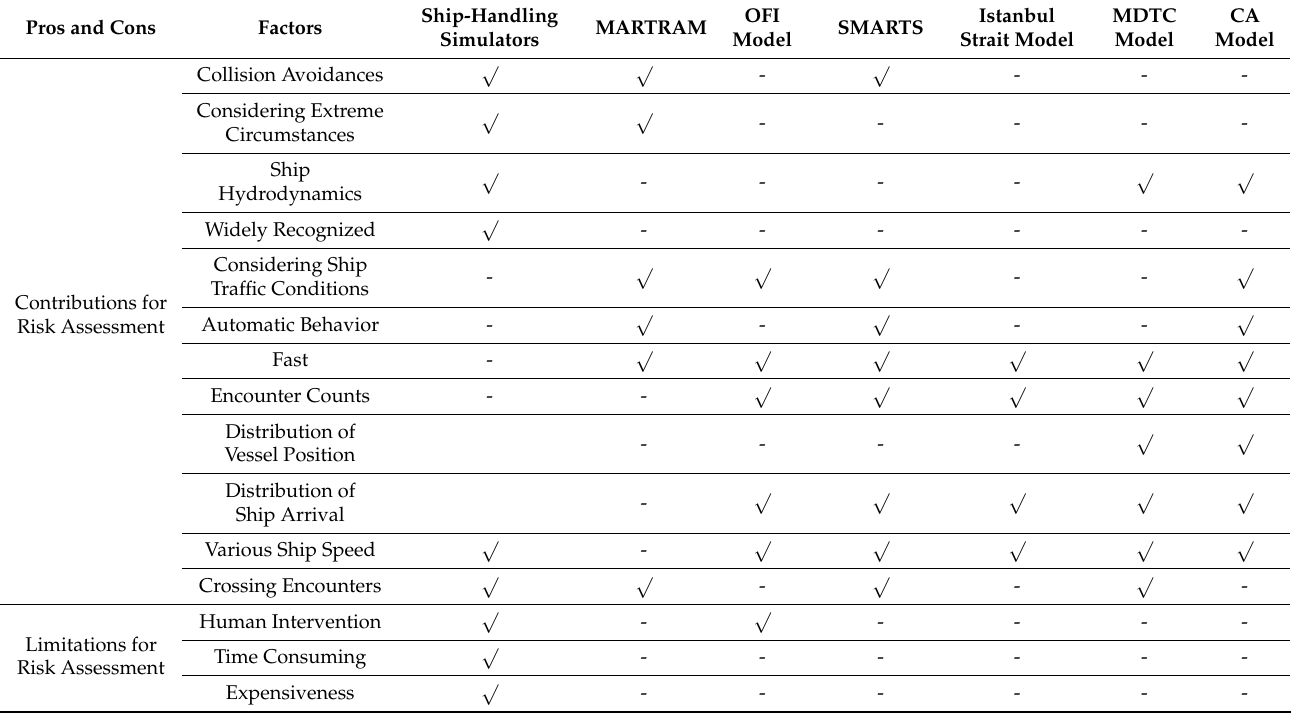
Table 2. Comparison of the simulation